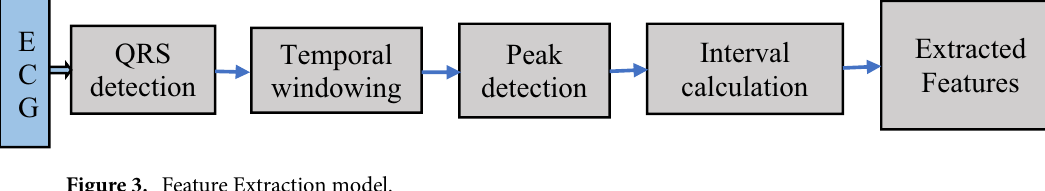
Figure 3. Feature Extraction